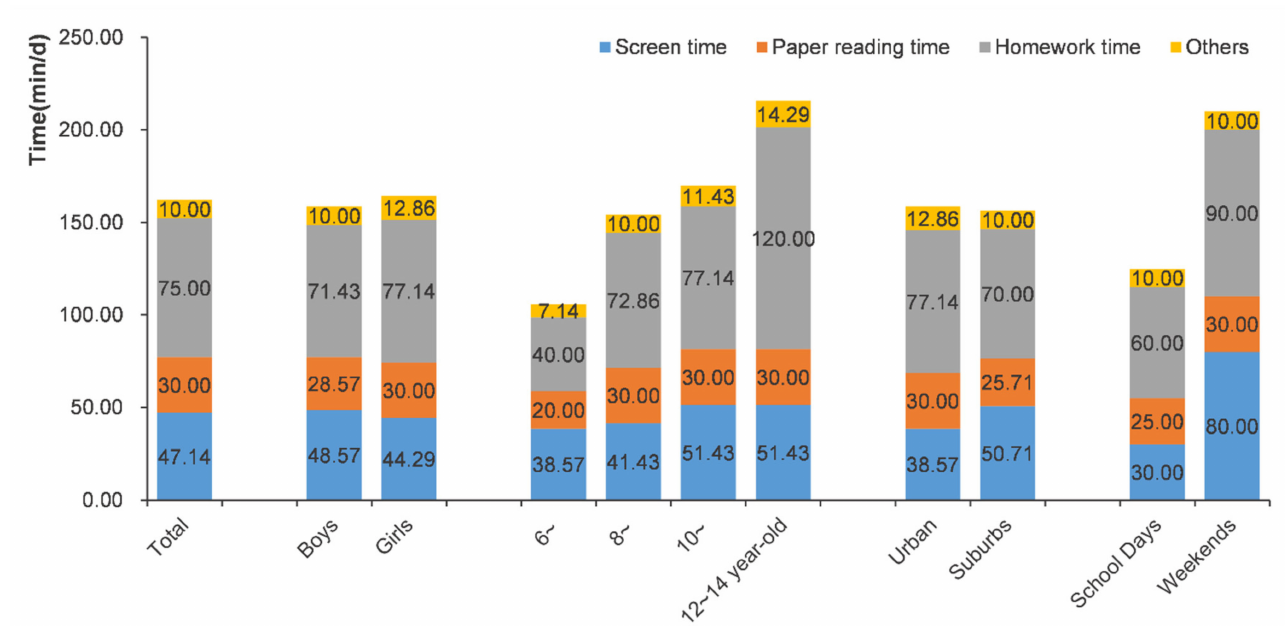
Figure 2. The composition of sedentary behavior time among children by gender, age, residence, and on school days or